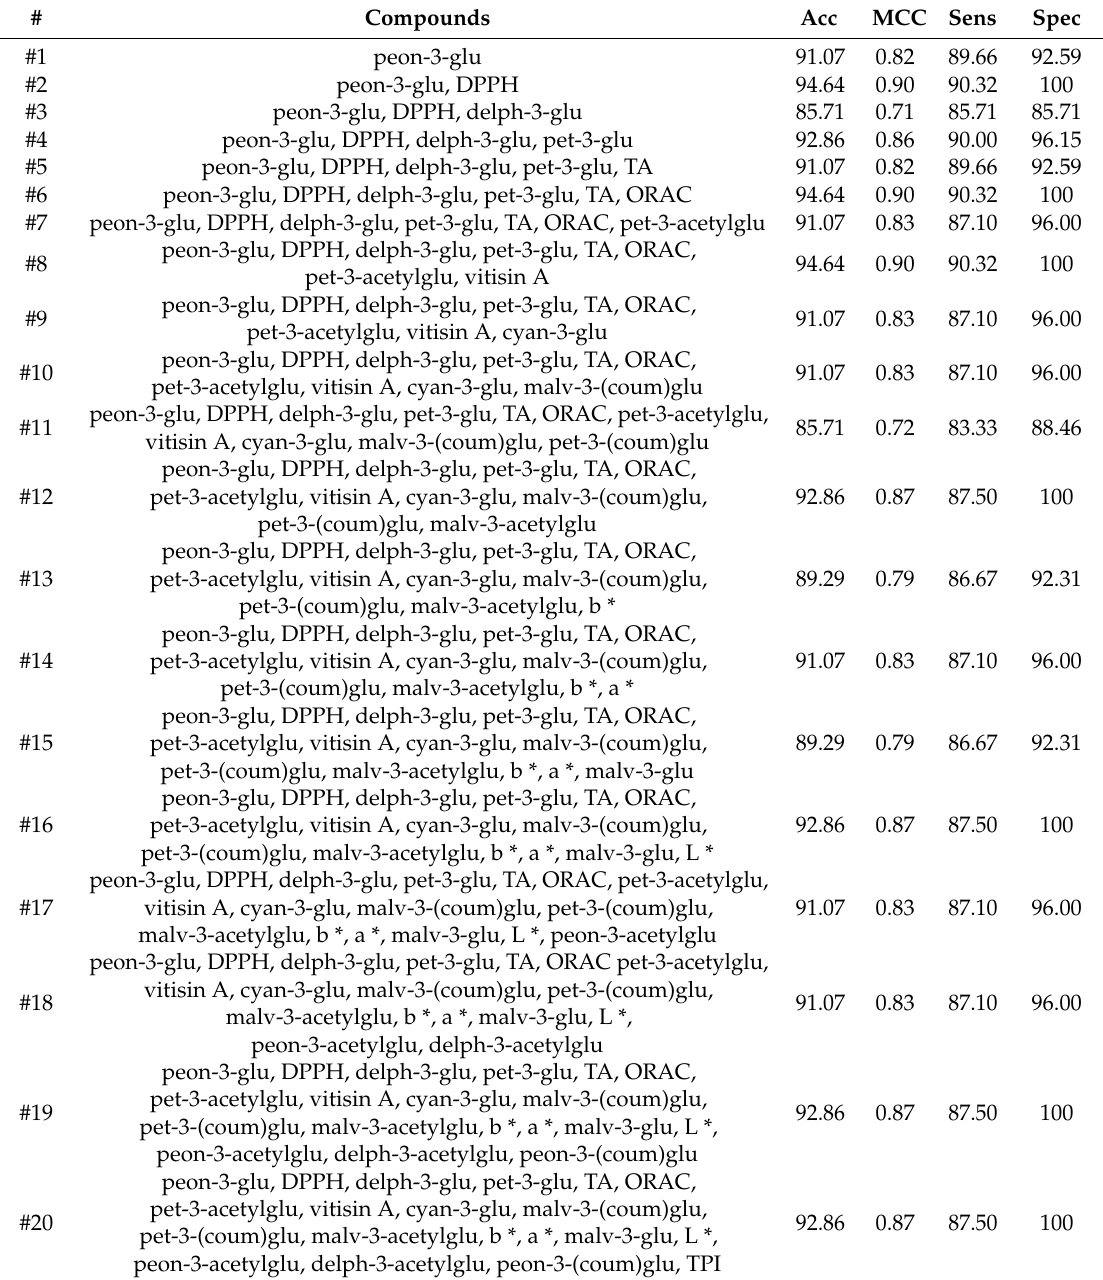
Table 3. Overall results from leave-one-out cross validation (LOOCV) classification with the support vector machine (SVM) for each feature